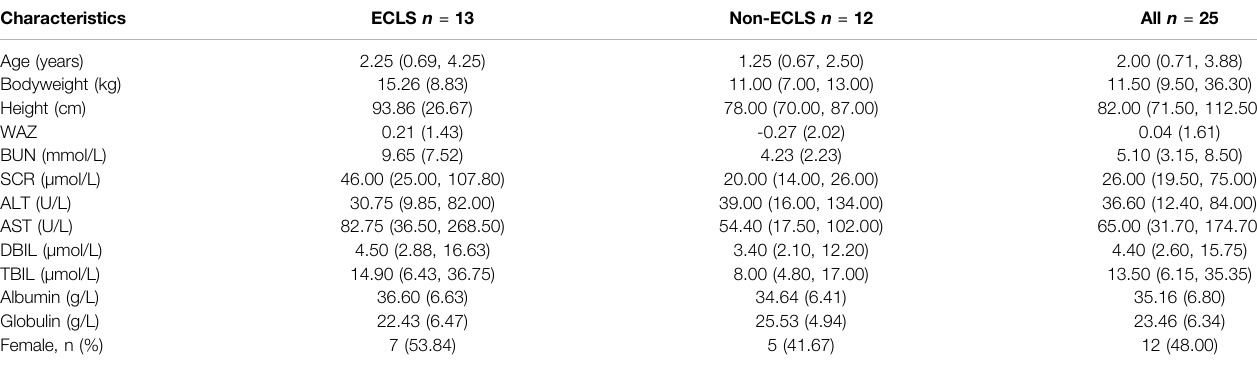
TABLE 2 | The demography of septic pediatric patients.